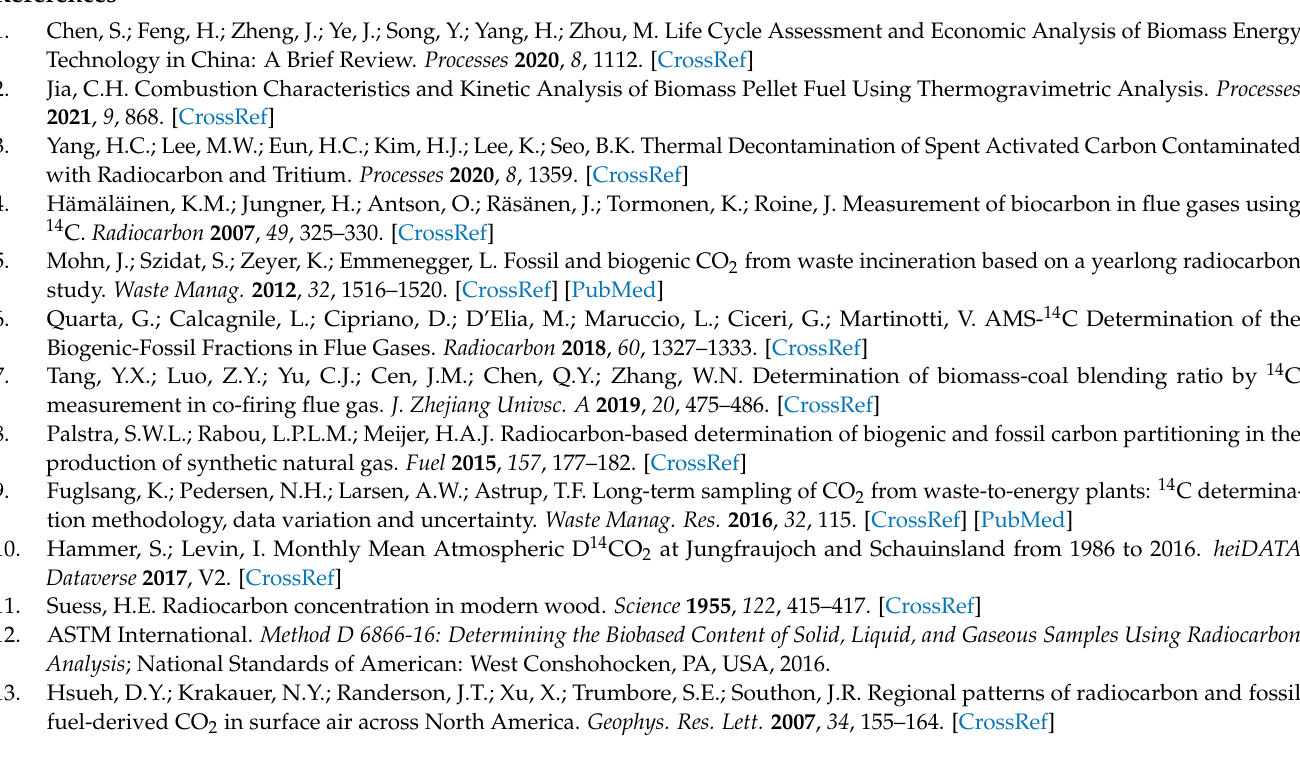
Table S1: 14 C activity of sampled annual crops and tree